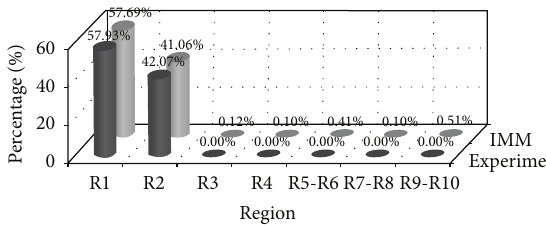
Figure 7: The energy absorbing distribution for experiment and IMM.